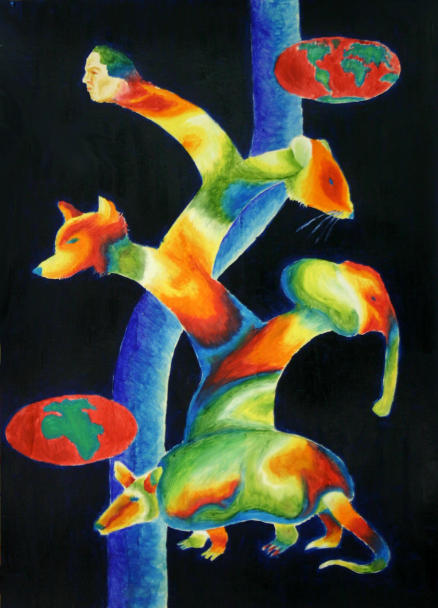
In this painting of the evolution of placental mammals, the blue time line connects two globes of different earth ages symbolizing the time scale of evolution. Major divergences of mammalian lineages are symbolized by members of crown groups. (Painting: Tomas Schmitz)